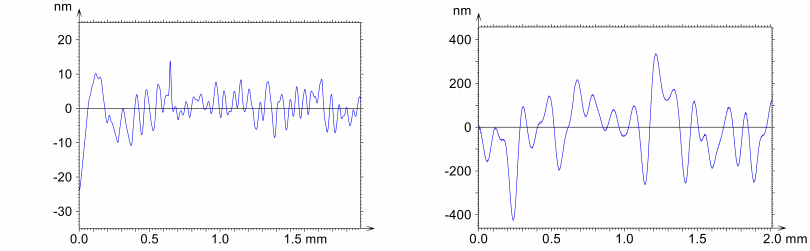
Figure 5. Surface profiles scan of PSAN thin films with wt = 1% ( left ) and wt = 10% ( right